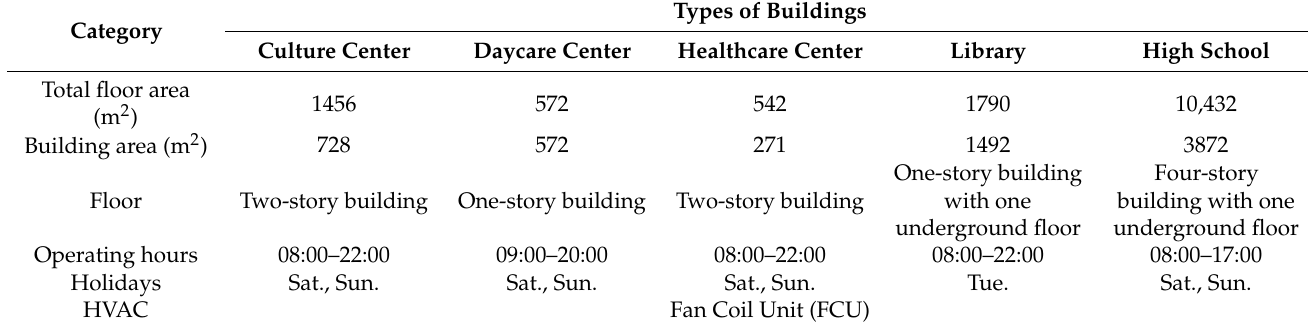
Table 3. Building